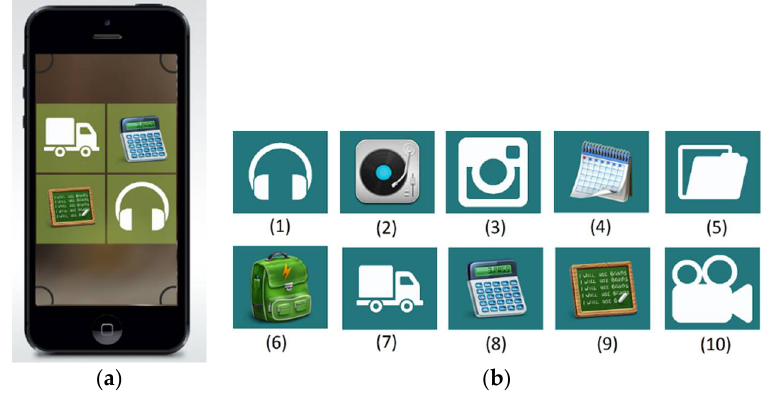
Figure 7. Screen displayed to users in Step 7 (click on the clock icon). Multimodal Technol. Interact. 2018 , 2 , x FOR PEER REVIEW